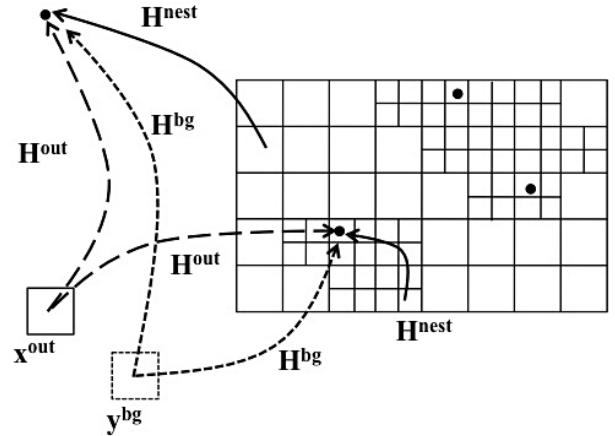
Figure 1. Schematic showing how the forward model is defined. The black dots represent receptors, the solid boxes represent grid- ded fluxes and the dotted box represents gridded mixing ratios from global model output. The arrows indicate transport to a receptor (which may be either inside or outside the nested domain): solid ar- rows show transport from fluxes within the nested domain, dashed arrows indicate transport from fluxes outside the nested domain, and the dotted arrows indicate transport of the mixing ratio at the point of back-trajectory termination. Each arrow can be thought of as an element (i.e. a partial derivative) in the transport matrix, H nest , H out , and H bg ,